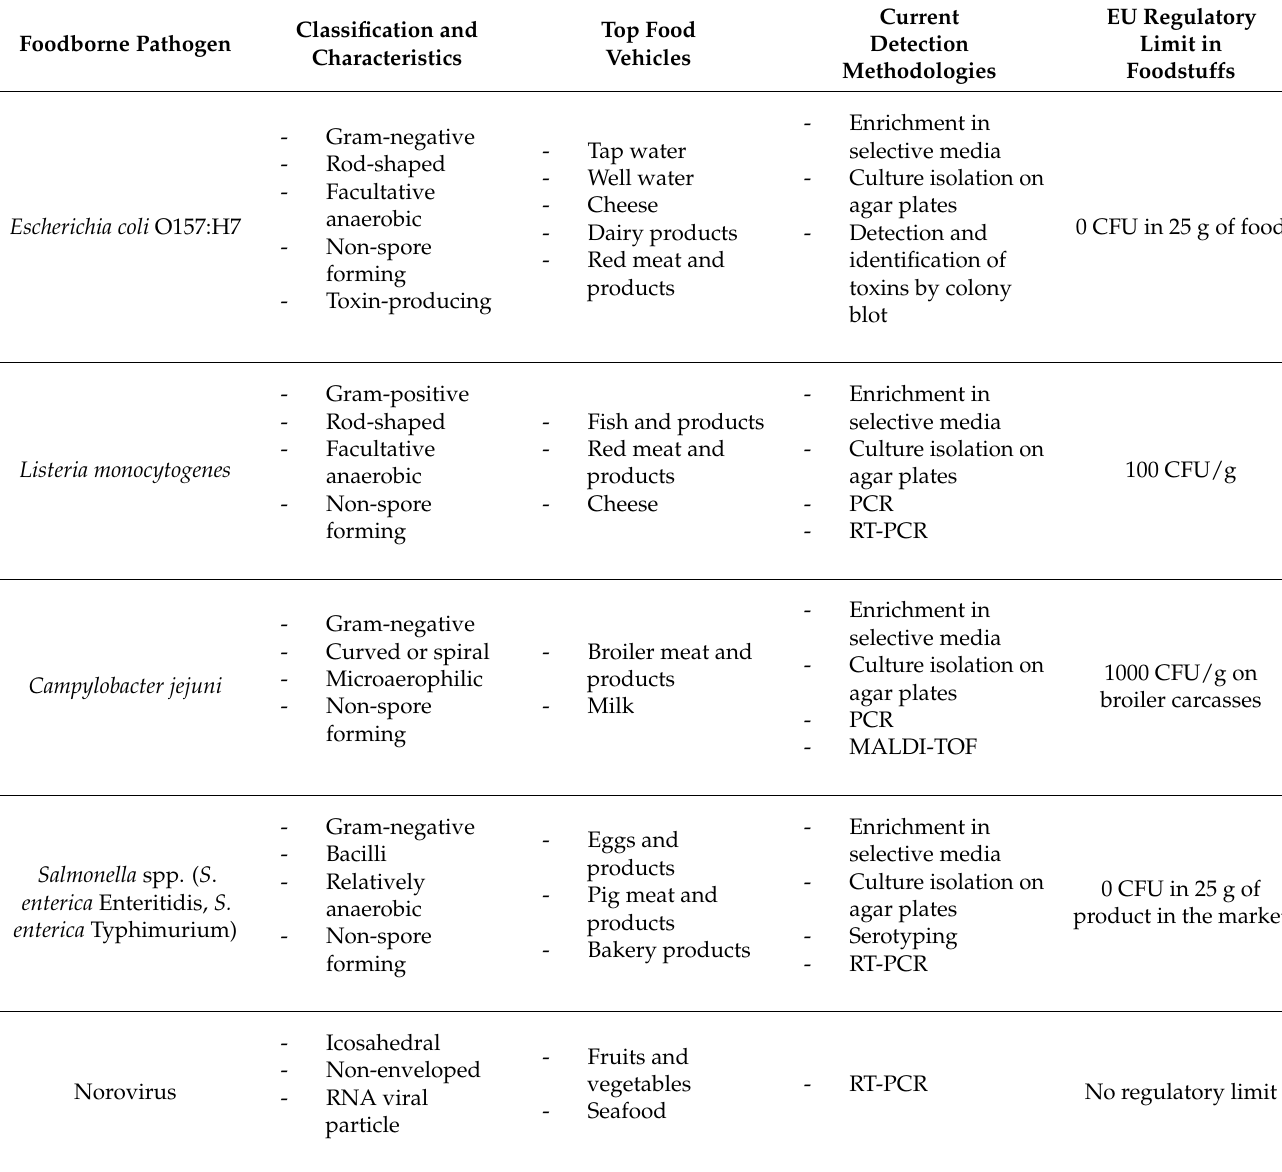
Table 1. Characteristics of the top foodborne pathogens worldwide and EU regulatory limits in foodstuffs